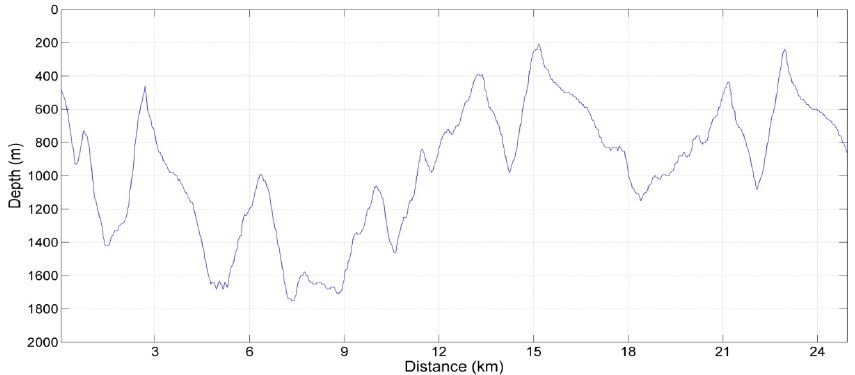
Figure 10. The velocity field of the Canadian Foothills model. The yellow lines show the locations of log L3, log L4, and log L5.